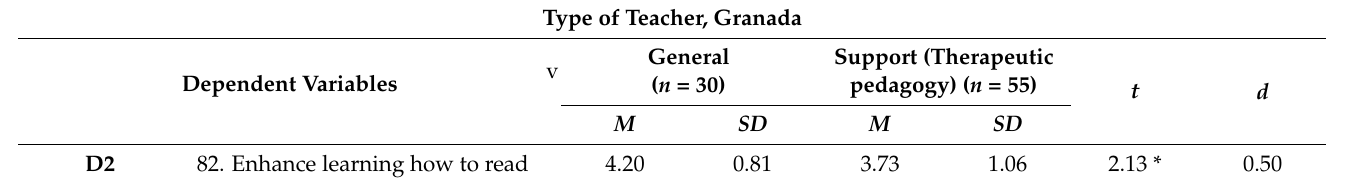
Table 14. Significant differences in the benefits and uses of apps as a function of the teaching position of the educators from